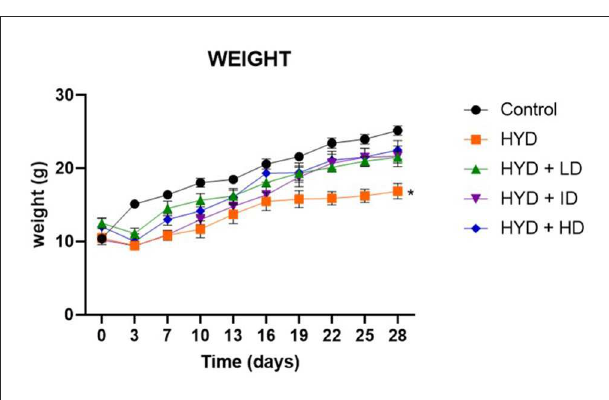
data sets were analyzed by GraphPad Prism 8.4 using Analysis of Variance test to compare the means of all groups and Tukey’s multiple comparison post-hoc test to compare within the groups. The statistical significance was set at p < 0.05.